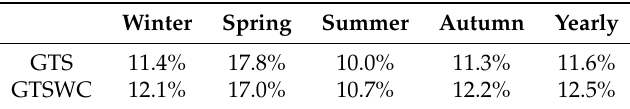
Figure 3. Self-consumption analysis. Statistical results for the self-consumption rates are shown for all seasons and an entire year. For each period, the reference case in which no storage is available is compared with a configuration that includes the optimally-sized batteries for each individual household for both the GTS and the GTSWC approaches. Table 1. Self-consumption improvements. The median improvement (over all households) of the self-consumption due to the introduction of optimally-sized batteries is shown. The simulations for each column were performed